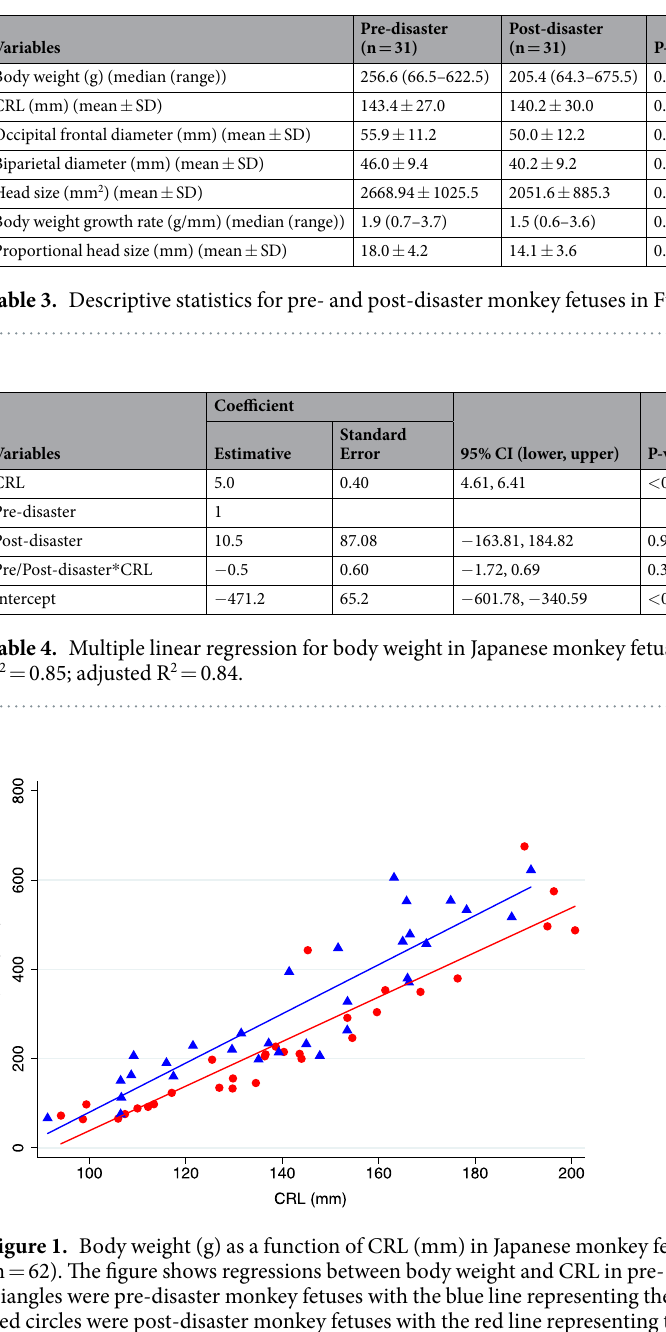
line (p < 0.0001) (Table 4). Regression lines describing association of head size and CRL in pre- and post-disaster groups were described in Fig. 2. Post-disaster regression line was significantly lower than pre-disaster regression line (p < 0.0001) (Table 5). The body fat index for the mothers of these fetuses was not significantly different before and after the NPP disaster (Z = 1.213; P = 0.219). Discussion